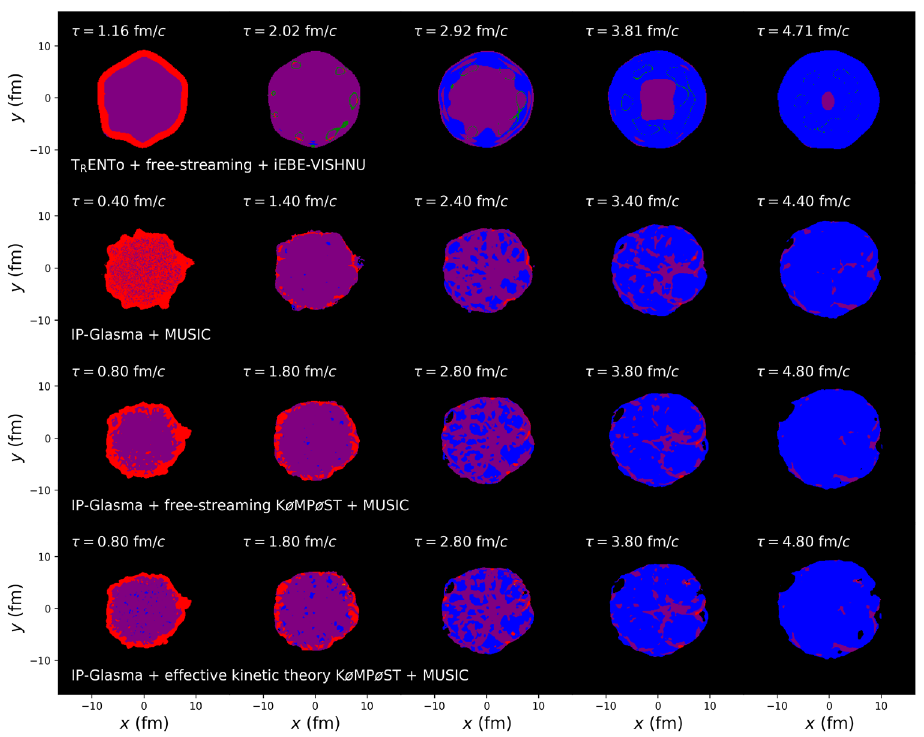
Figure 1. From top to bottom: the TFV scenario and the three IKM scenarios (no KøMPøST, free- streaming KøMPøST, EKT KøMPøST). Colors correspond to the following cell classifications: cer- tainly causal (blue), certainly acausal (red), and purple (indeterminate). Taken from Ref.